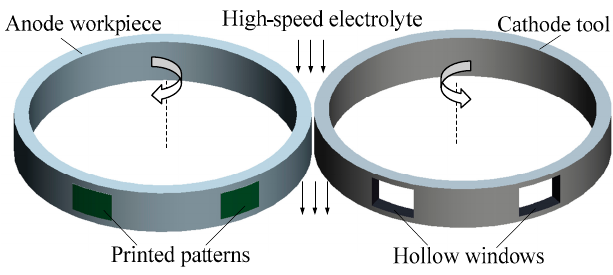
Figure 1. Principle of the electrochemical machining (ECM) test of revolution surface.